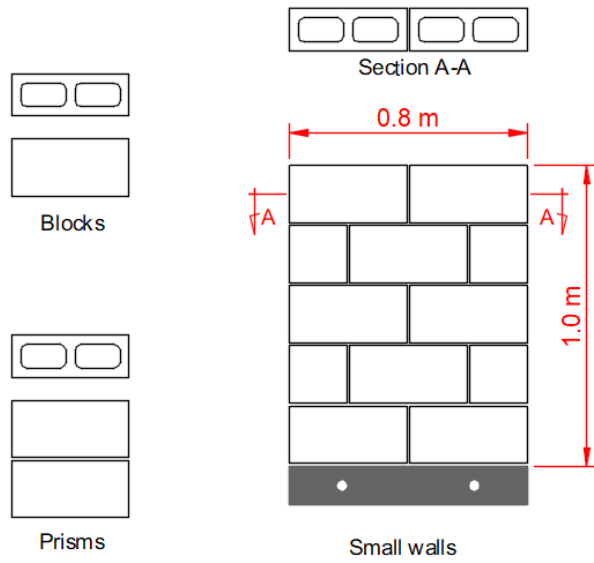
Figure 1. Test specimens: blocks, prisms and small